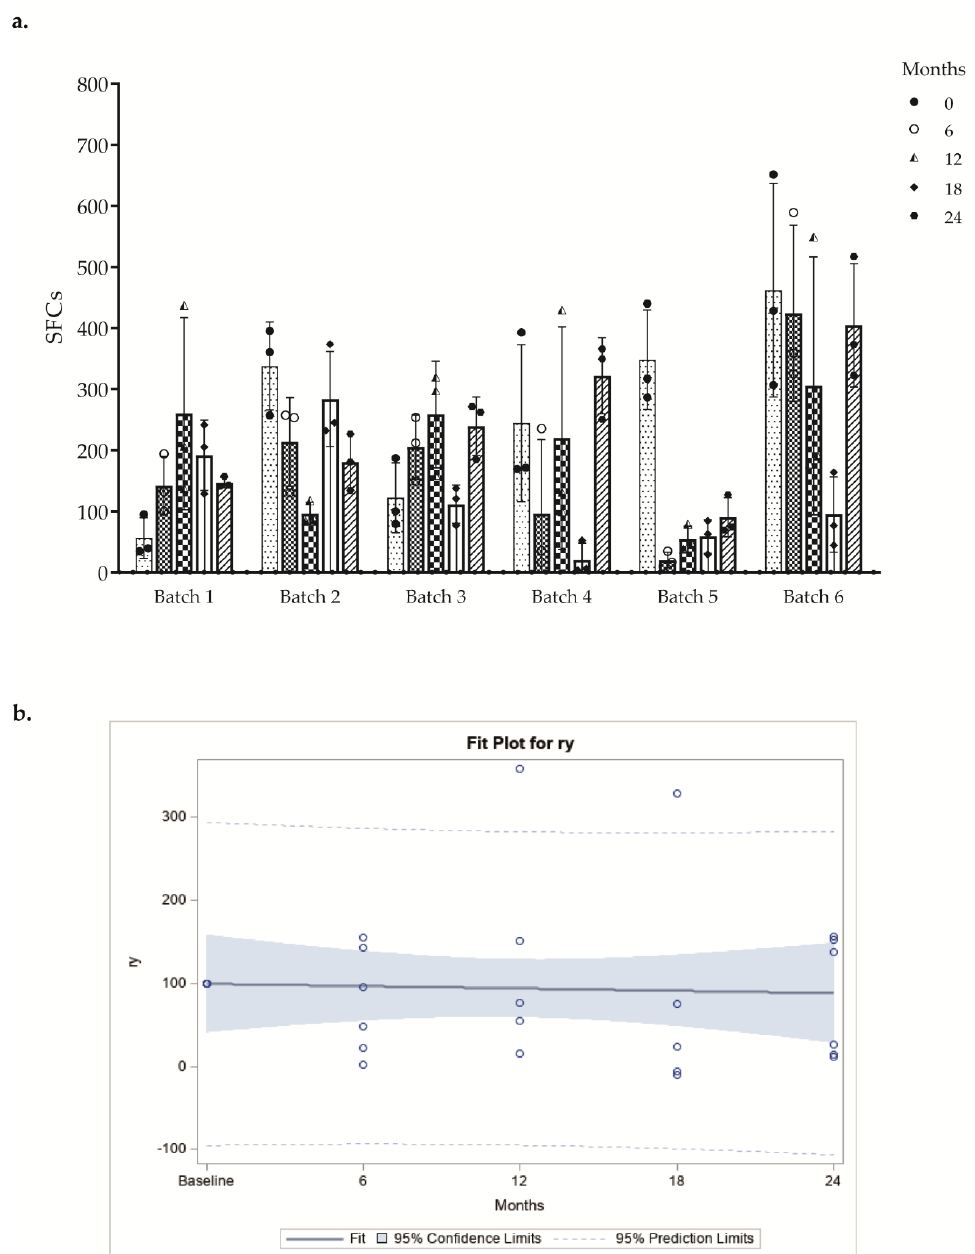
Figure 4. ( a ) Results of the ELISPOT Costim assay are shown as a bar ‐ plot of SFCs (mean ± SD) at several time points. The different symbols shapes represent the mean of quadruplicate of each activated CD3+ T cell donor. ( b ) Regression analysis of poolability of all batches. Pooled regression line of the batches resulting after the tests of equality of slopes and intercepts of the regression lines. Each circle represents the mean value of the replicates of each donor at different time